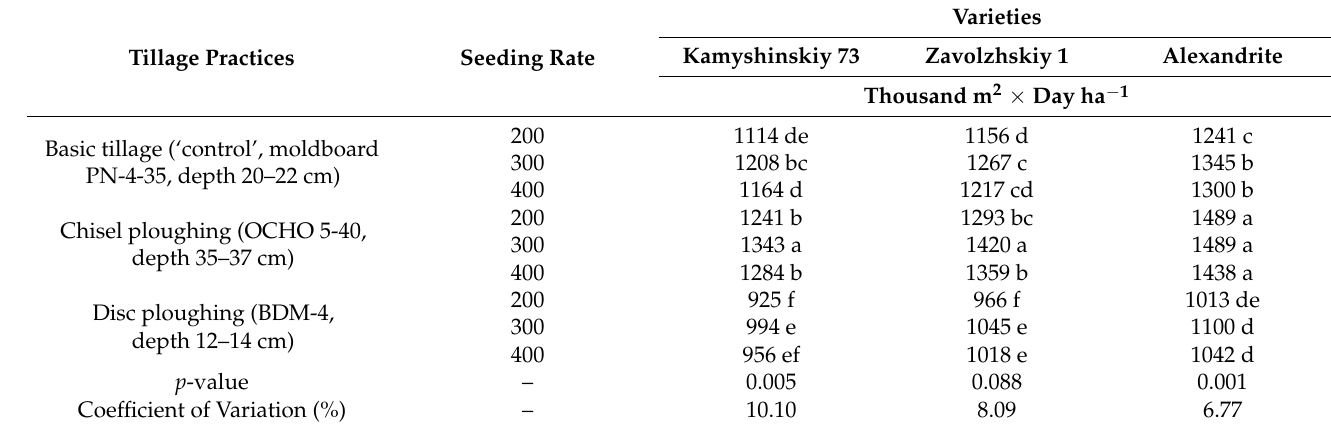
Table 2. Interactive efficacy of the various tillage practices and seeding rates on photosynthetic potential of safflower average in 2018–2020.